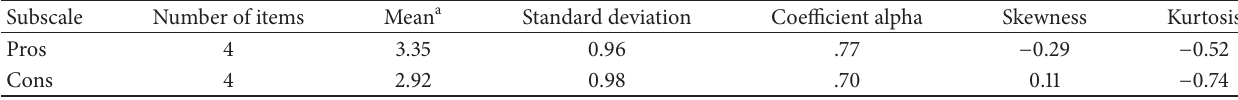
Table 3: Summary statistics for Pros and Cons subscales of Decisional Balance ( 𝑁 = 1336).